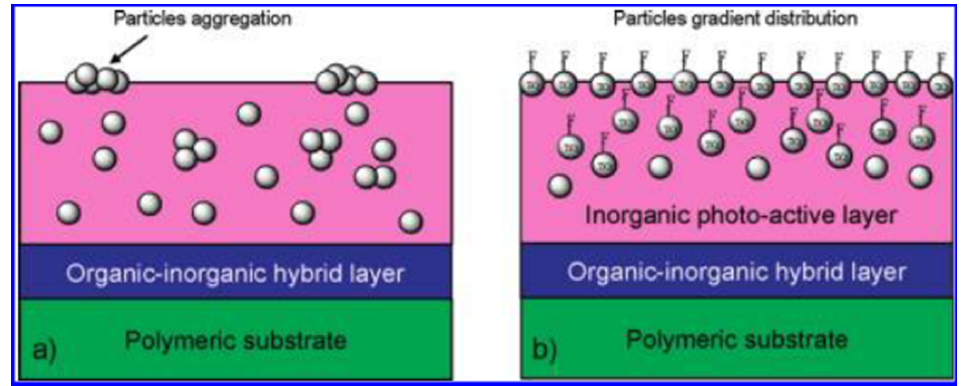
Figure 10. Schematic illustration of the multilayer functional coating on PLA substrate with ( a ) TiO 2 nanoparticles without surface fluorination, ( b ) surface fluorinated TiO 2 nanoparticles [6].